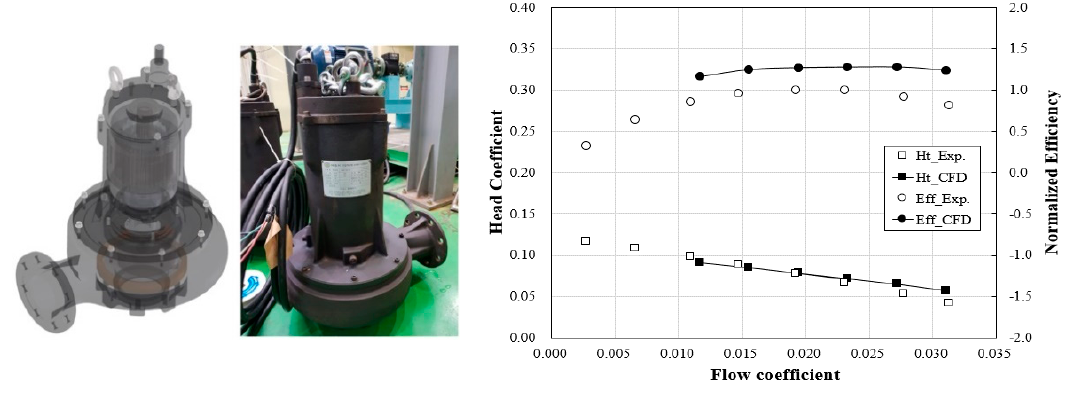
Figure 12. Validation data of previous study [29].